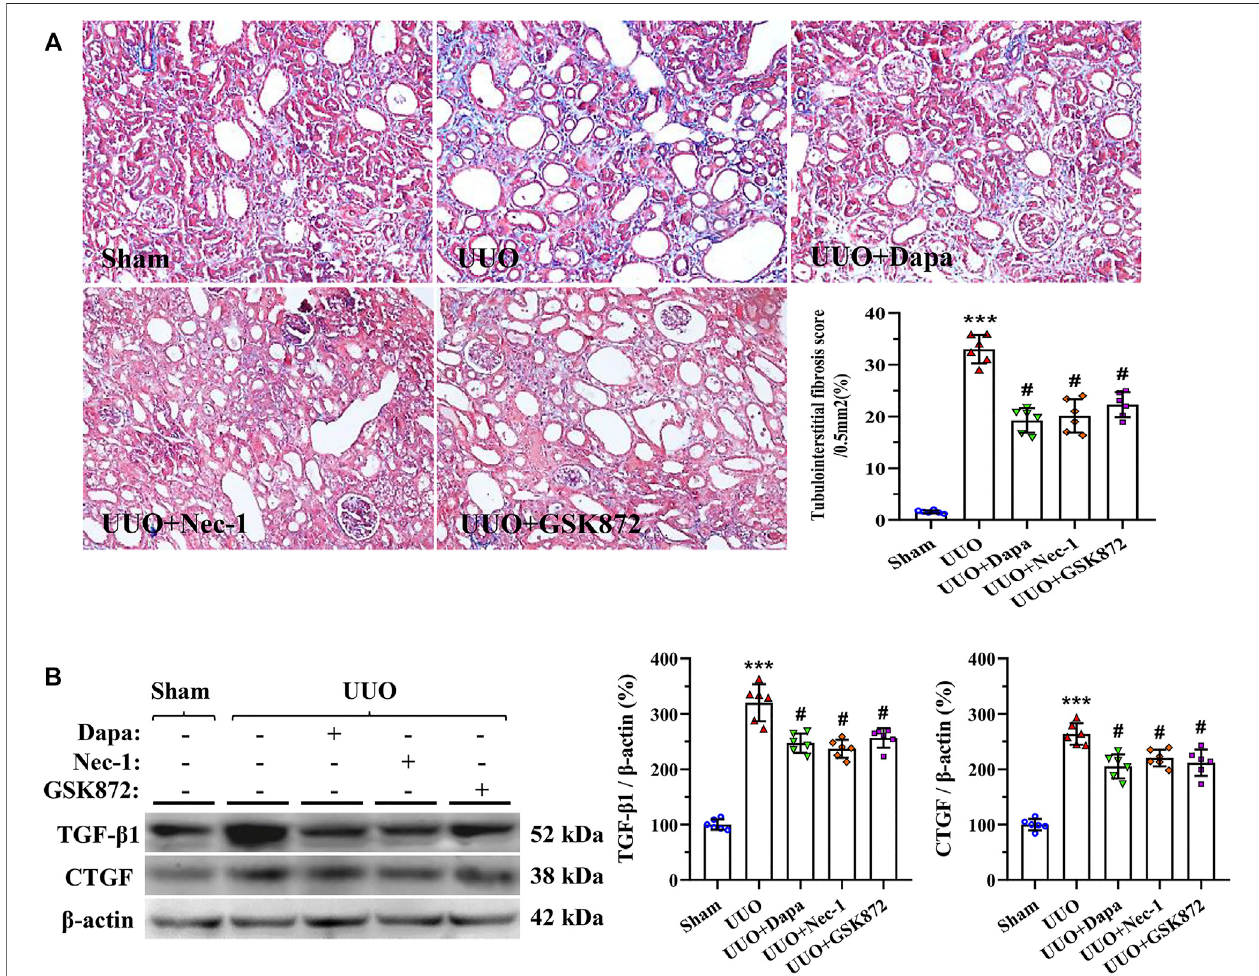
FIGURE 3 | Representative photomicrographs of Masson trichrome staining (A) and immunoblotting analysis of TGF- β 1 and CTGF (B) . Data are presented as mean ± SEM ( n (cid:2) 6) and analyzed by one-way ANOVA. *** p < 0.01 vs sham; # p < 0.05 vs UUO.